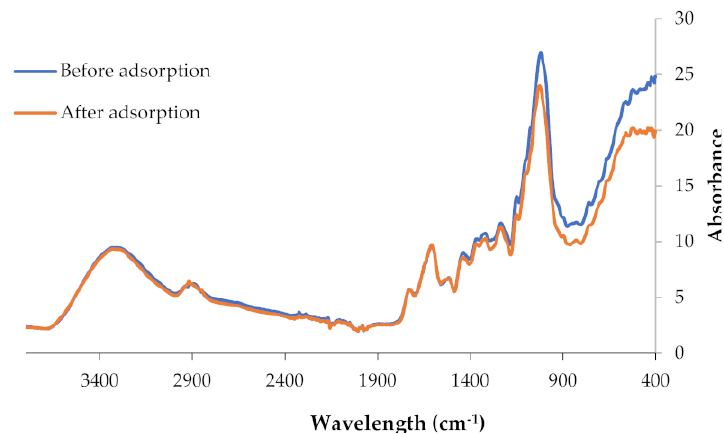
Figure 3. Characterization of chestnut shell by FTIR-ATR analysis.